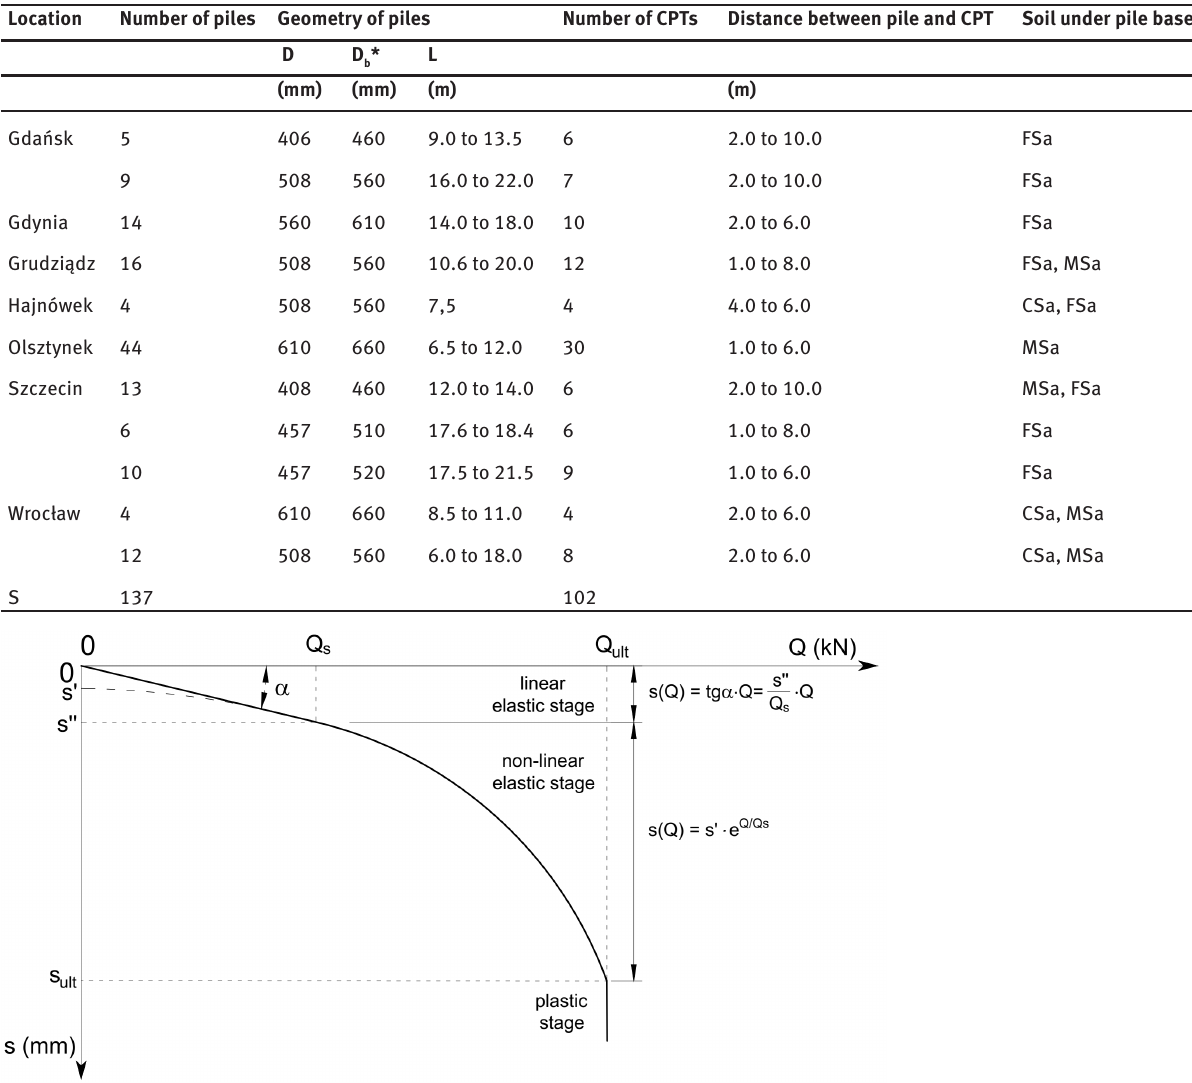
Table 1: Compilation of data used for correlation analysis. Location